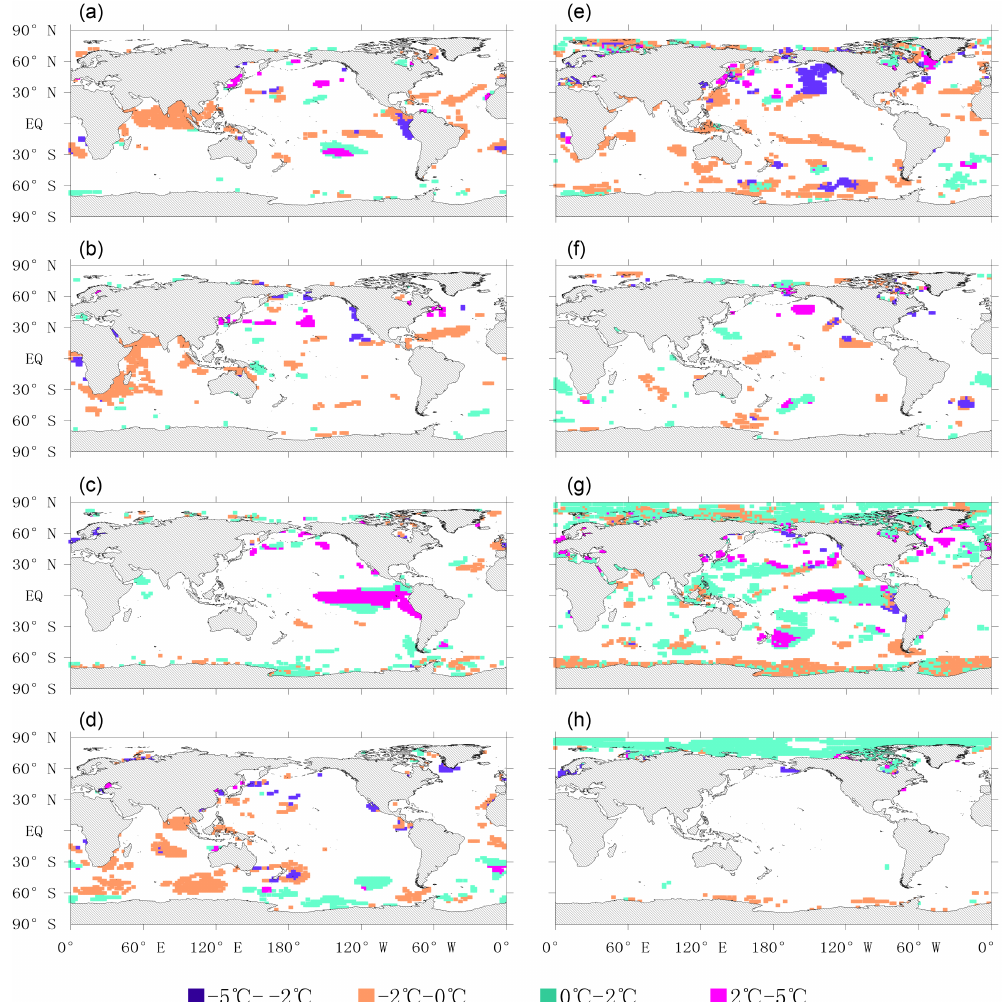
Figure 5. Amplitude distributions of abrupt changes in different periods: (a) is the abrupt change in 1878, (b) is the abrupt change in 1896– 1898, (c) is the abrupt change in 1900–1903, (d) is the abrupt change in 1908–1909, (e) is the abrupt change in 1942, (f) is the abrupt change in 1976, (g) is the abrupt change in 1989–1999, and (h) is the abrupt change in